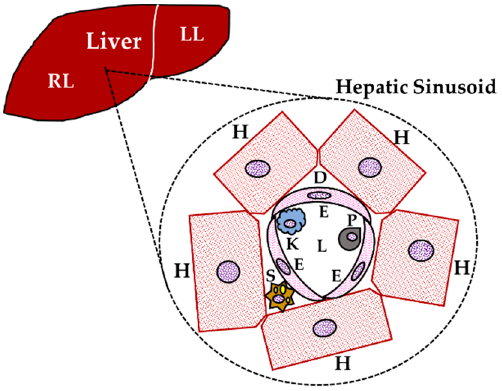
Figure 1. Scheme of the liver and hepatic sinusoid. Liver right lobe (RL), left lobe (LL), and the hepatic sinusoid that is composed by hepatocytes (H), sinusoidal endothelial cells (E), macrophage Kupffer cell (K), natural killer or pit cell (P), Ito or stellate cell (S), space of Disse (D), and lumen (L).